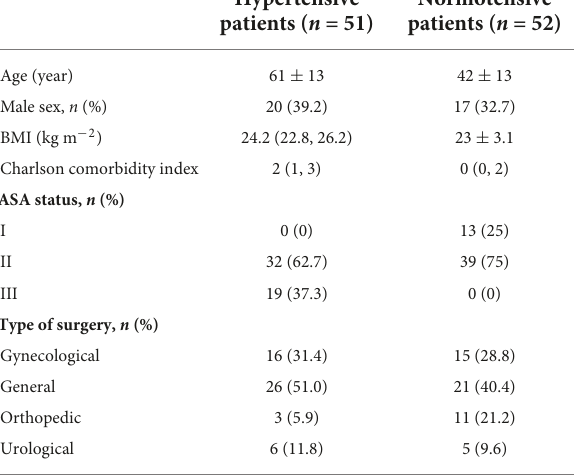
TABLE 1 Demographic and baseline characteristics of the hypertensive versus normotensive